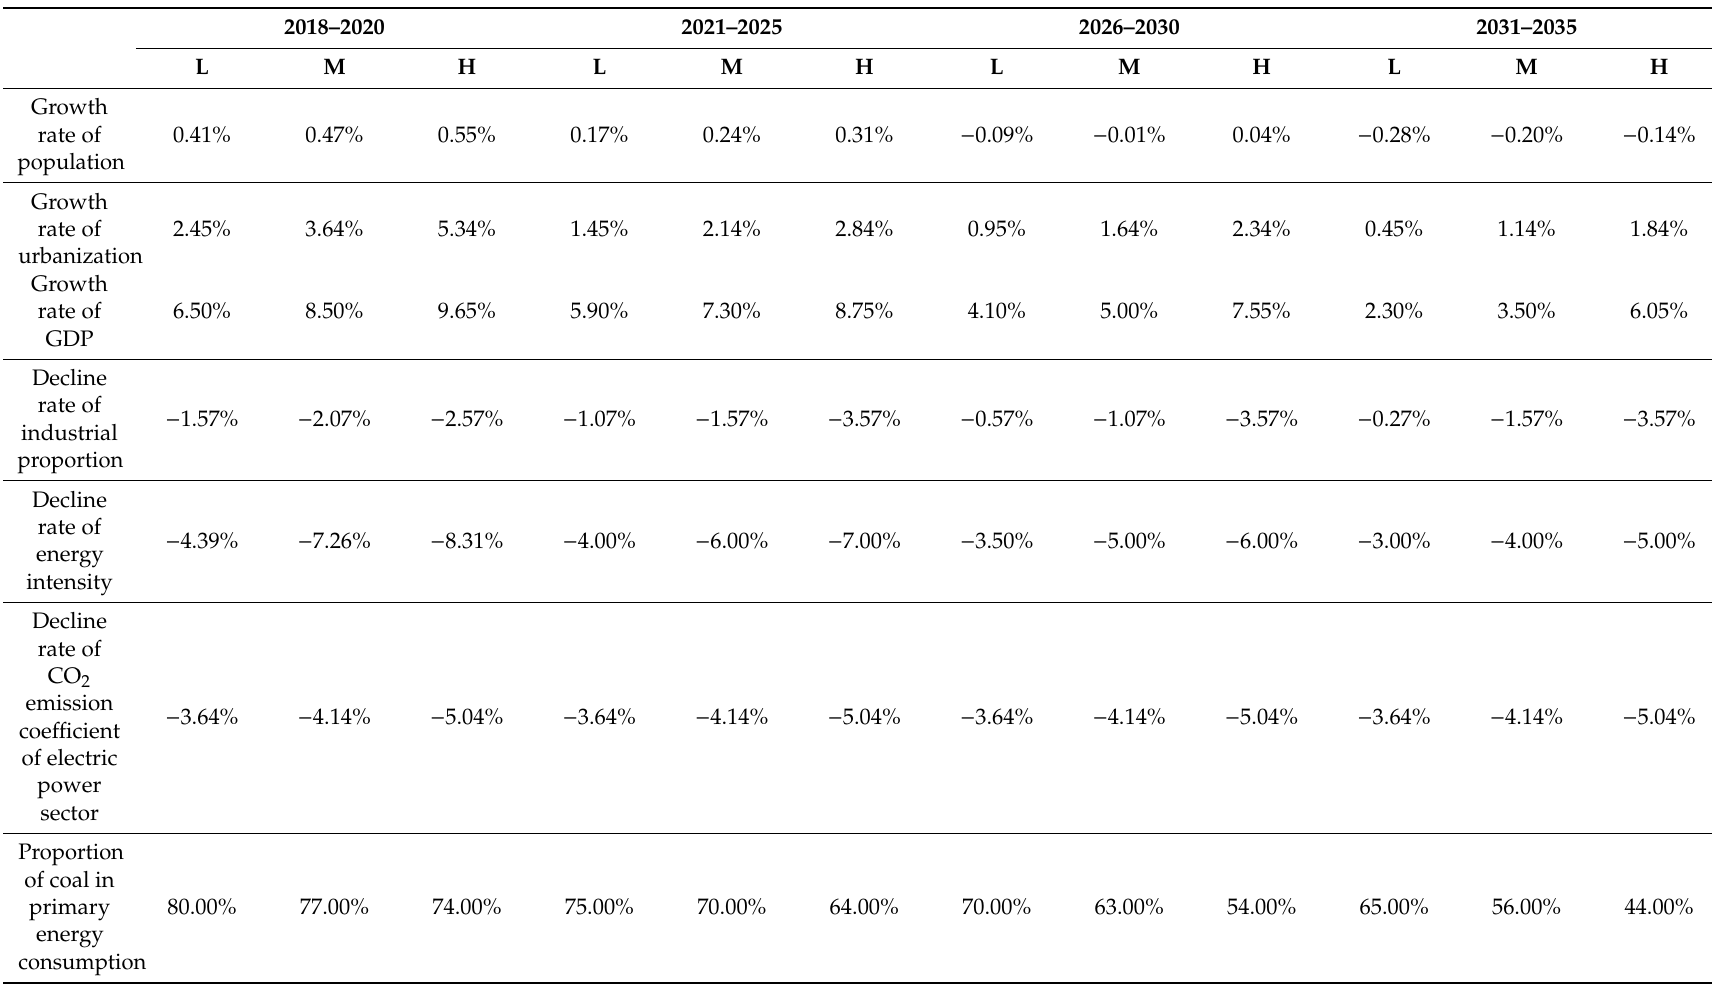
Table 2. Parameter settings in low (L), medium (M), and high (H) speed development